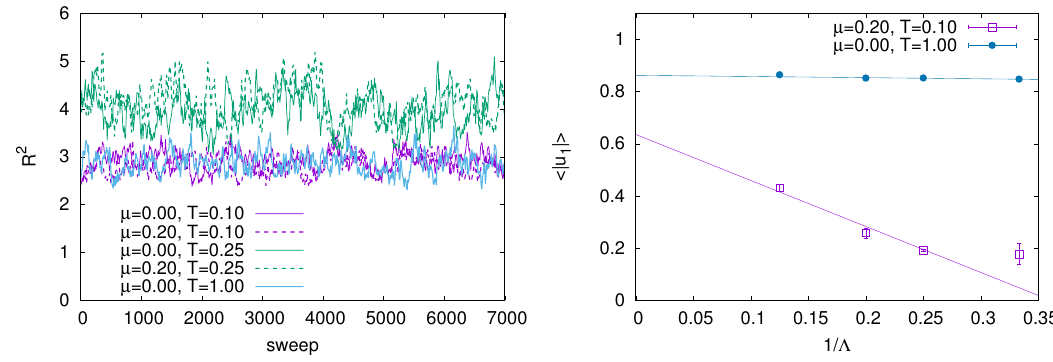
Figure 7 . (Left) The history of R 2 for D = 3 ; N = 16 ; (cid:3) = 3. (Right) An example of the large-(cid:3) extrapolation for D = 3 ; N =